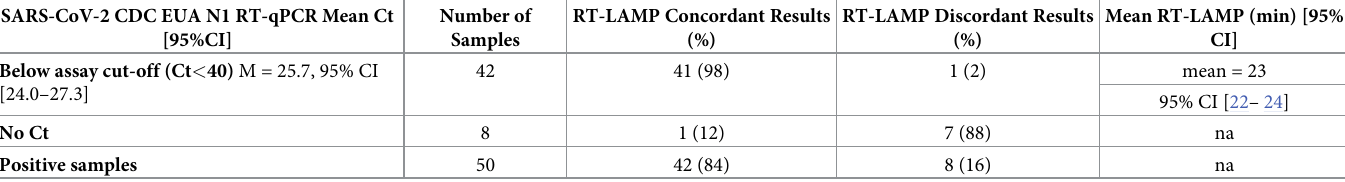
Table 1. Fluorescent RT- LAMP on SARS-CoV-2 positive NP swab samples.